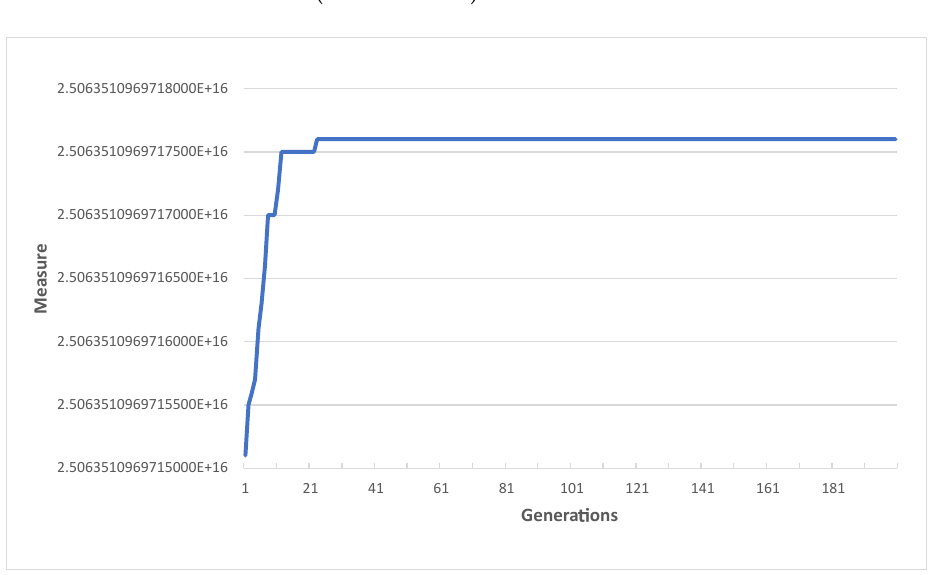
Figure 4. The performance of the genetic algorithm in Section 4.3 according to the number of generations.